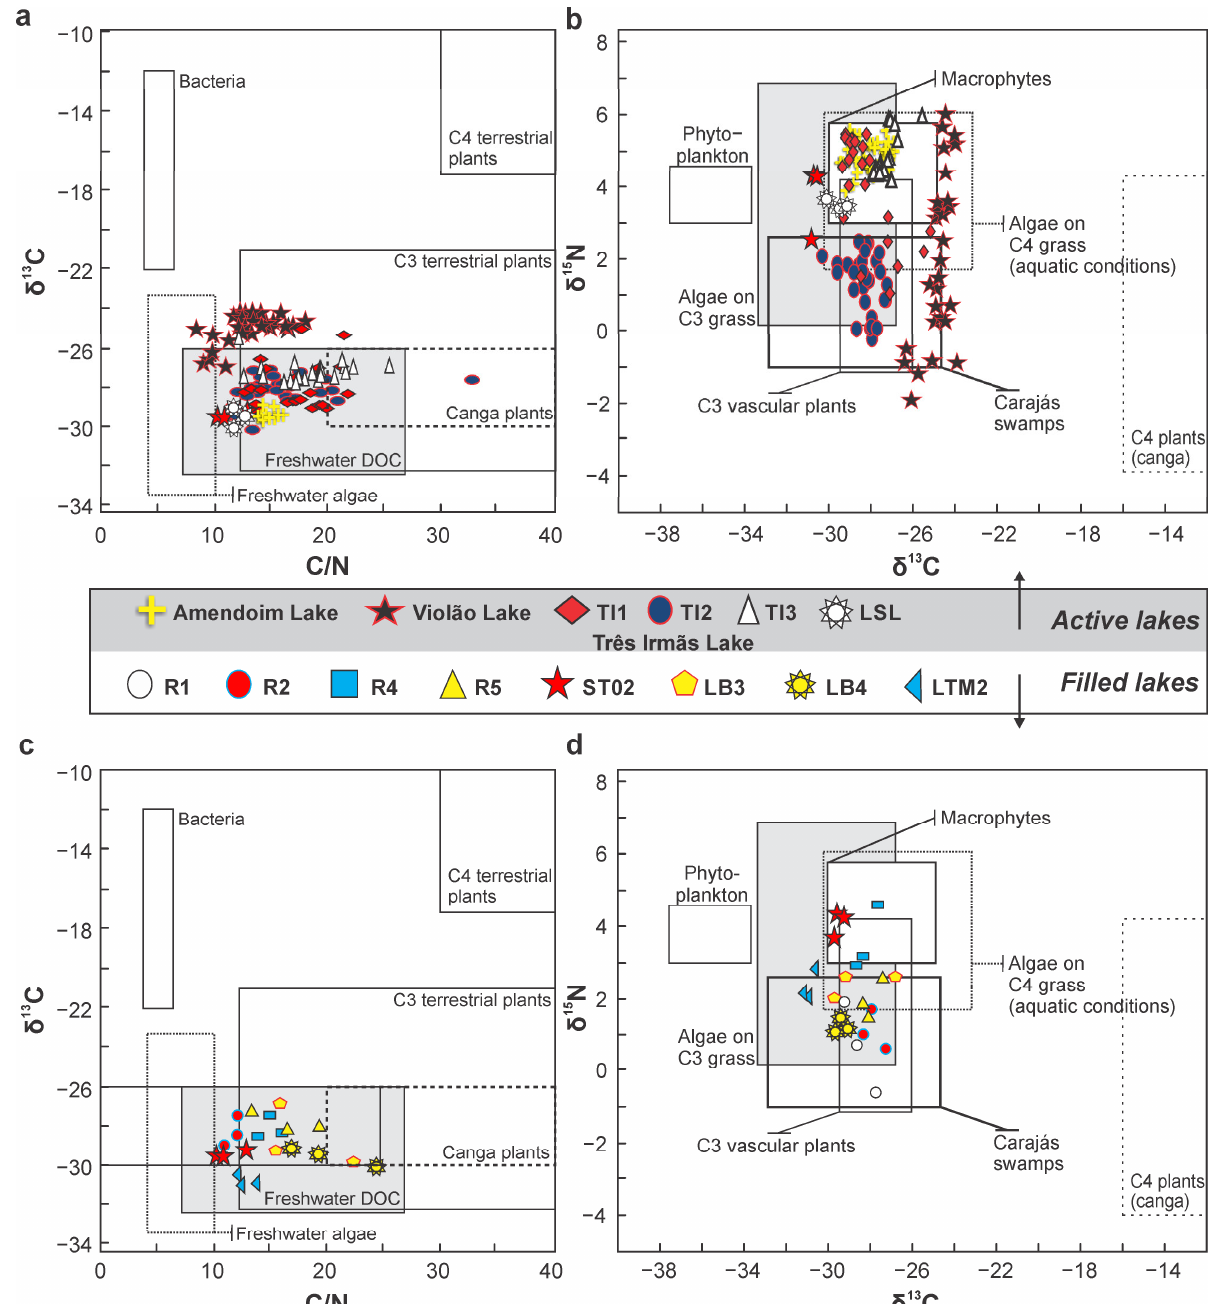
Figure 7. Binary plots of ( a ) δ 13 C vs. C/N and ( b ) δ 15 N vs. δ 13 C of the surface sediments of the active ULs (modified from Sahoo et al., 2019), and ( c ) δ 13 C vs. C/N and ( d ) δ 15 N vs. δ 13 C of sediment cores from filled ULs of the Carajás mountain range (fields based on [5–7,9,17,55–62]).